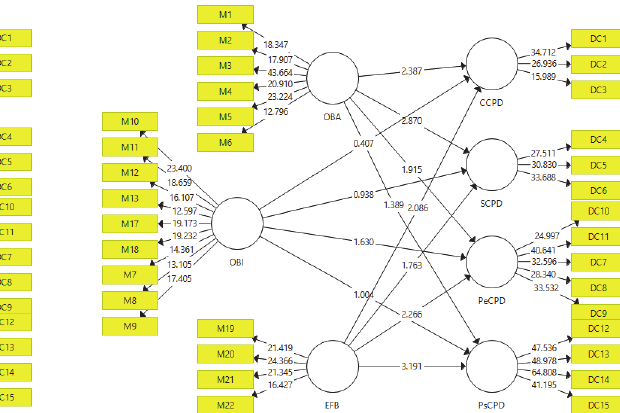
Fig. 2. Results for the hypothesized model with structural equations